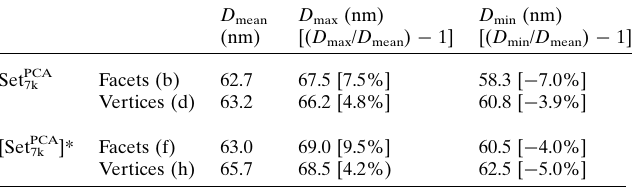
Table 2 Particle size determined from facet to facet and vertex to vertex distances shown in Fig. 11. The background subtracted data set is indicated by [ ... ]*.